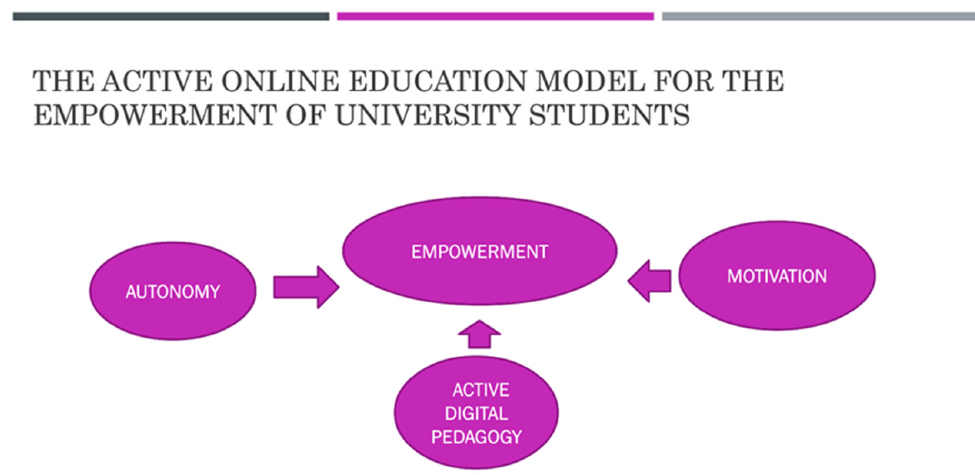
Figure 1. The active online education model for the education of students.